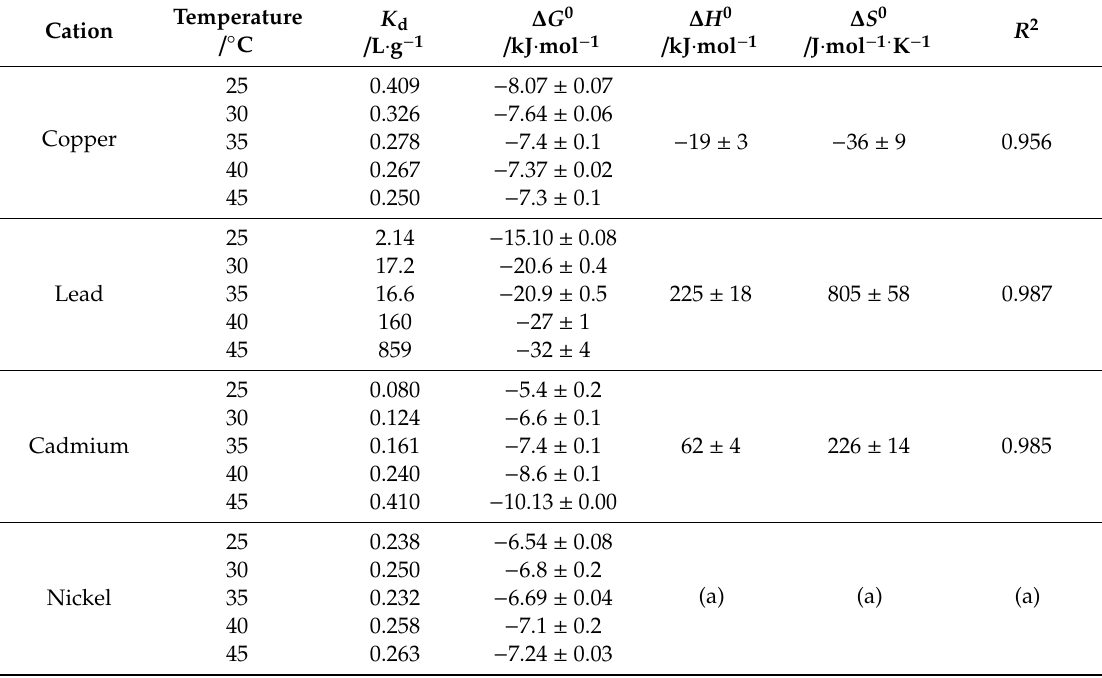
(a) Adsorption performance does not change with temperature—Figure 7. Molecules 2020 , 25 , x FOR PEER REVIEW